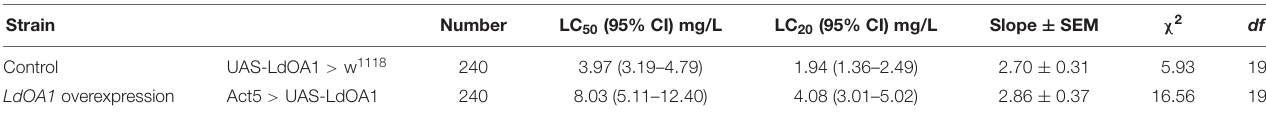
TABLE 1 | Deltamethrin toxicity on LdOA1 overexpression and control